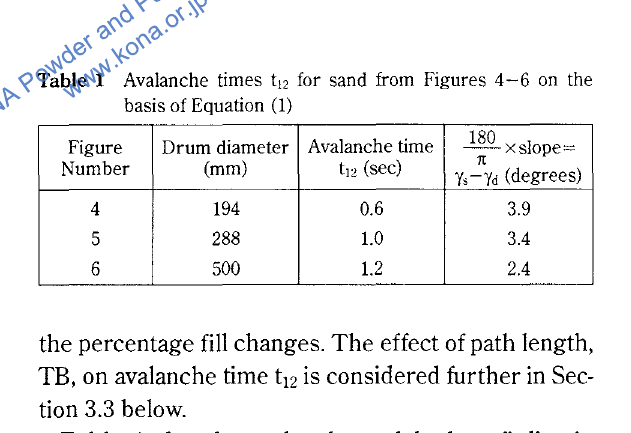
Fig. 7 Slump cycle time against 1/ (angular speed) for Titanium Dioxide powder of wide size range